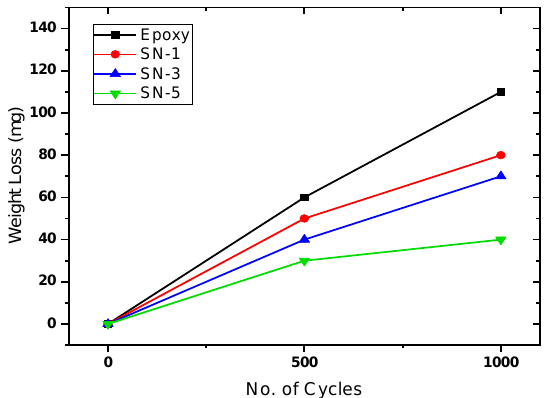
Figure 5. Indentation modulus of SNP formulated epoxy coatings.